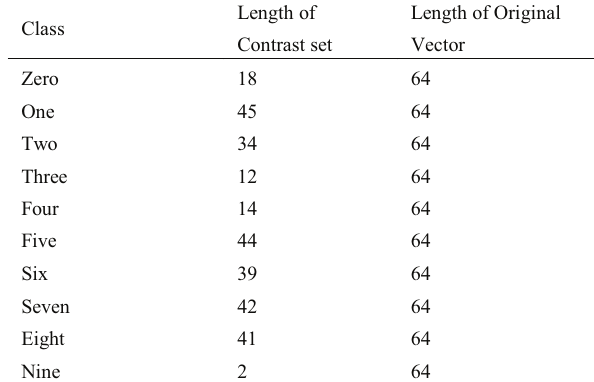
Table 4. Lengths of the discovered contrast sets of the Optical Recognition of Handwritten Digits dataset.